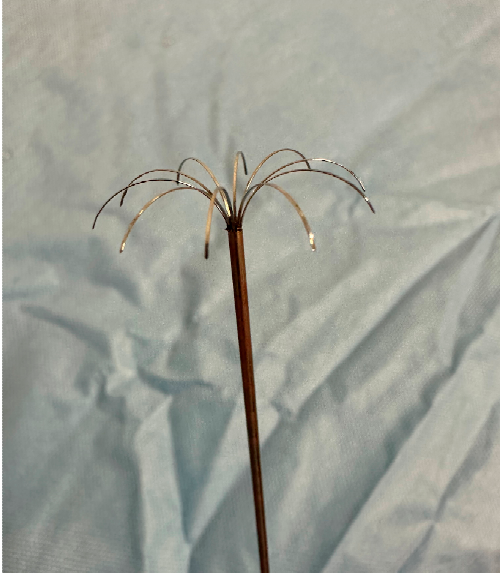
Figure 1. Radiofrequency ablation (RFA) probe with expandable system.